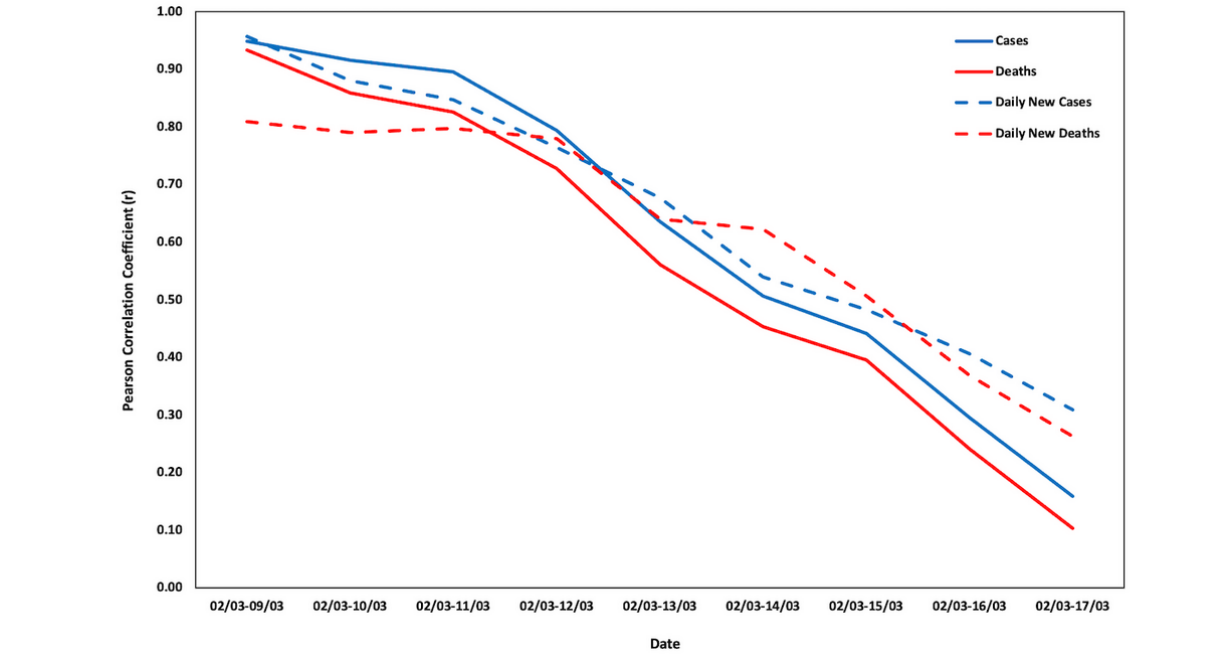
Figure 4. Changes in the Pearson correlation coefficients ( r ) for Italy.